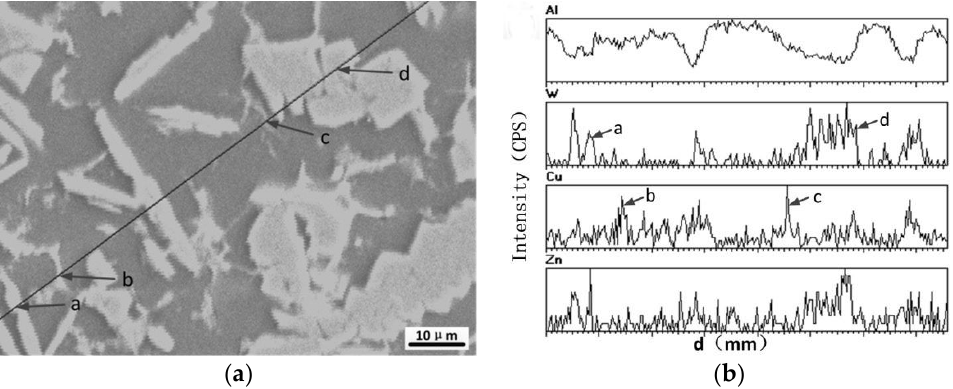
Figure 10. ( a ) SEM image; ( b ) EDS results of the cladding layer prepared with 60 wt.% WC powders.